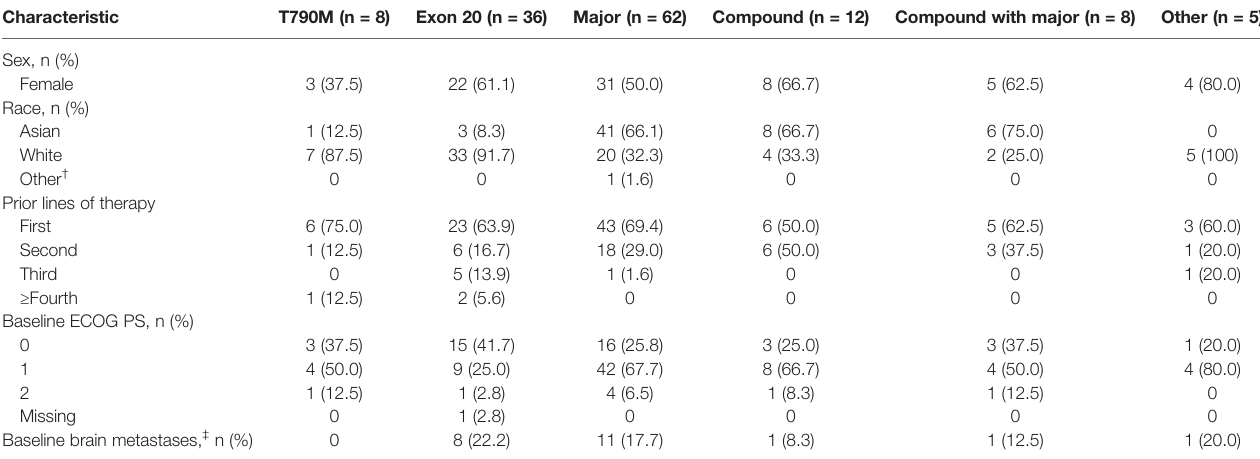
TABLE 4 | Baseline demographics and disease characteristics according to the type of uncommon EGFR mutation.